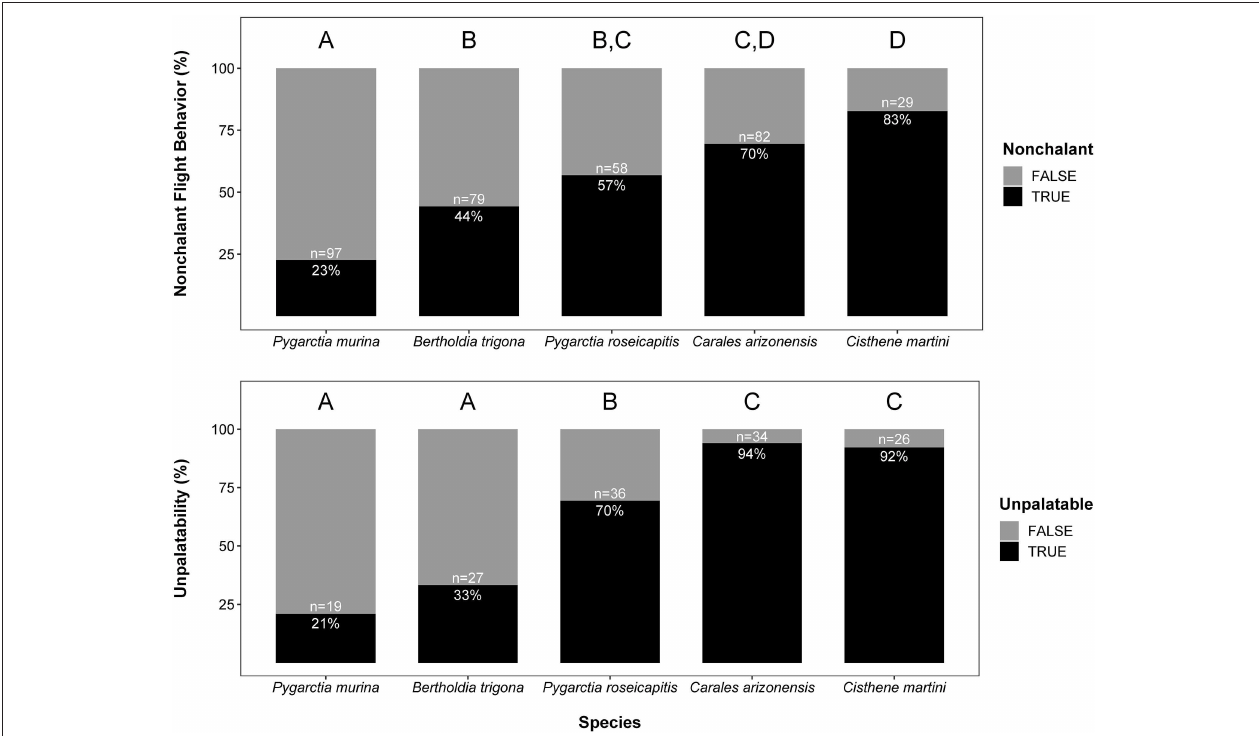
FIGURE 1 | Interspecific variation in nonchalant flight behavior and unpalatability. Sample sizes for each species and the percentage exhibiting either nonchalant flight or unpalatability are given within each bar. Significantly different groups within each plot are indicated by different letters (see Tables 1 , 2 for more info).